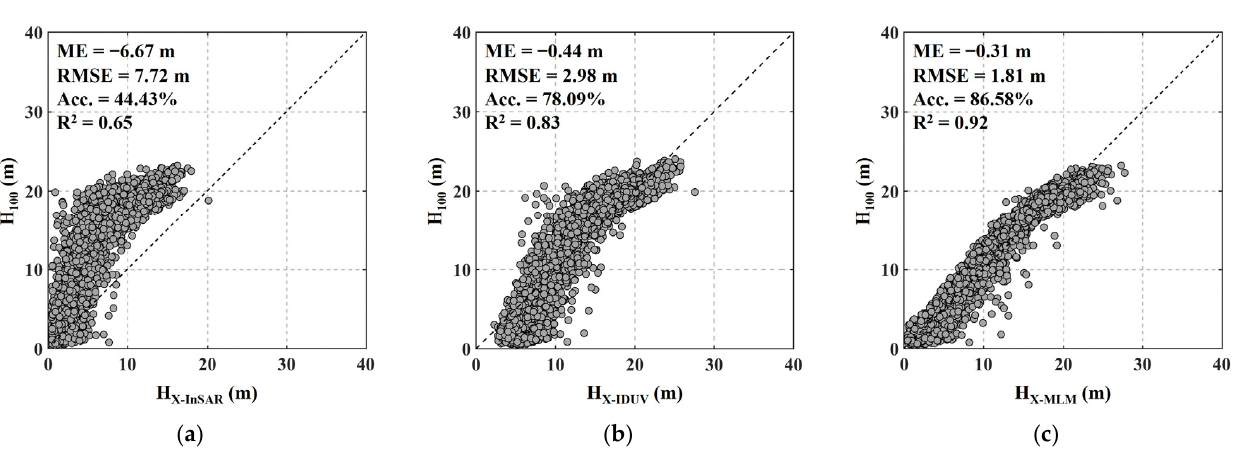
X-InSAR; ( b ) H X-IDUV;